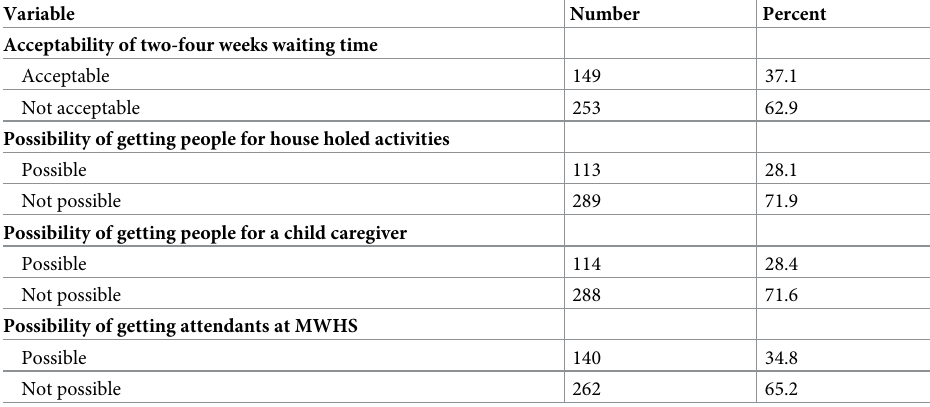
Table 3. Social and behavioral factors for MWHs utilization, Dabat district, northwest Ethiopia, 2019.